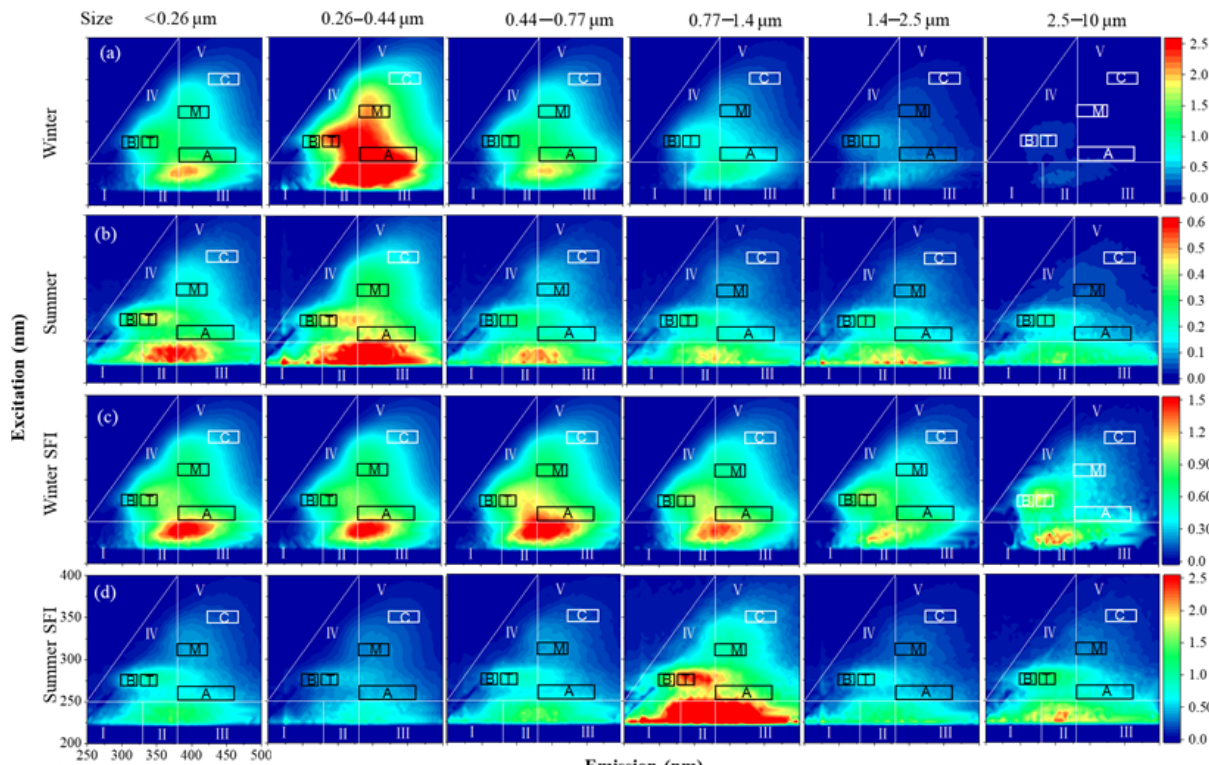
Figure 2. The excitation–emission matrix (EEM) spectra of size-segregated samples in winter and summer; their excitation and emission wavelength ranges were the same and are only shown in the first EEM (left panel) in (d) . All spectra were partitioned into five regions and were assigned as protein-like pollutants (I and II), fulvic acid (III), soluble microbial byproduct-like substances (IV), and humic-like acid (V), respectively (Birdwell and Engel, 2010). Peaks A, B, C, M, and T were generally considered as humic-like fluorophores, tyrosine-like fluo- rophores, humic-like carbon with larger molecular weight, marine humic-like fluorophore, and tryptophan-like fluorophores (Coble, 1996). Rows (a) and (b) show the size-segregated EEM spectra of the winter and summer samples, respectively (unit: RU), and rows (c) and (d) show the corresponding EEM spectra of fluorescence emitted per unit of WSOC carbon (unit: RULmg − 1